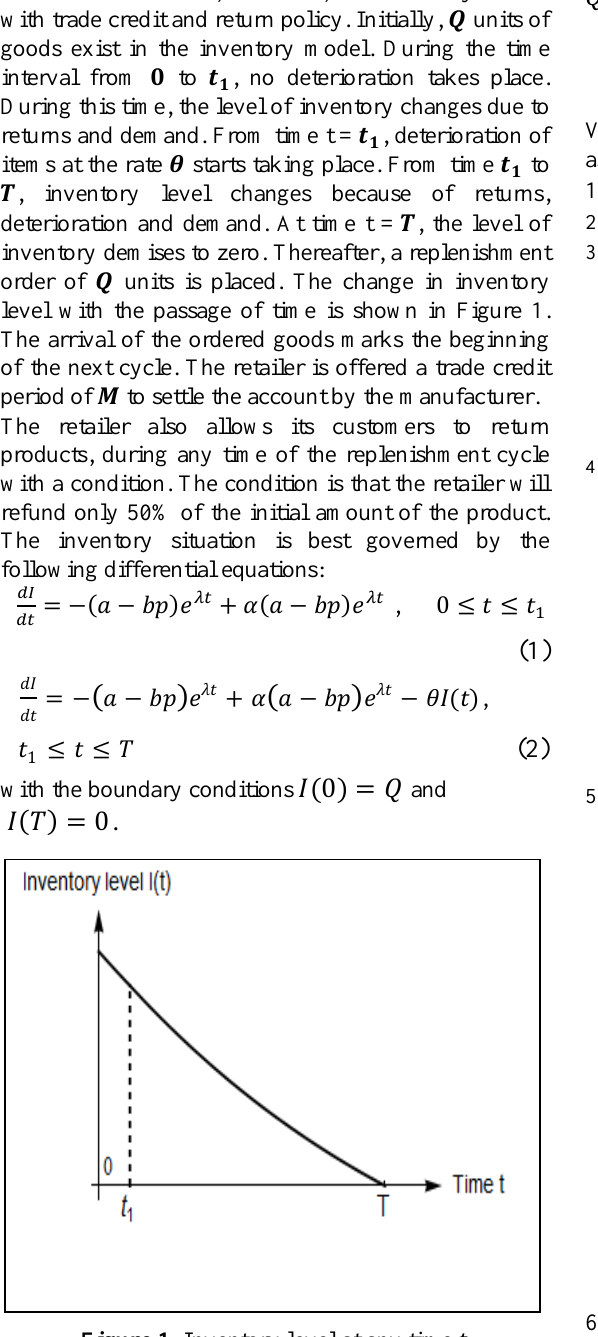
Figure 1. Inventory level at any time